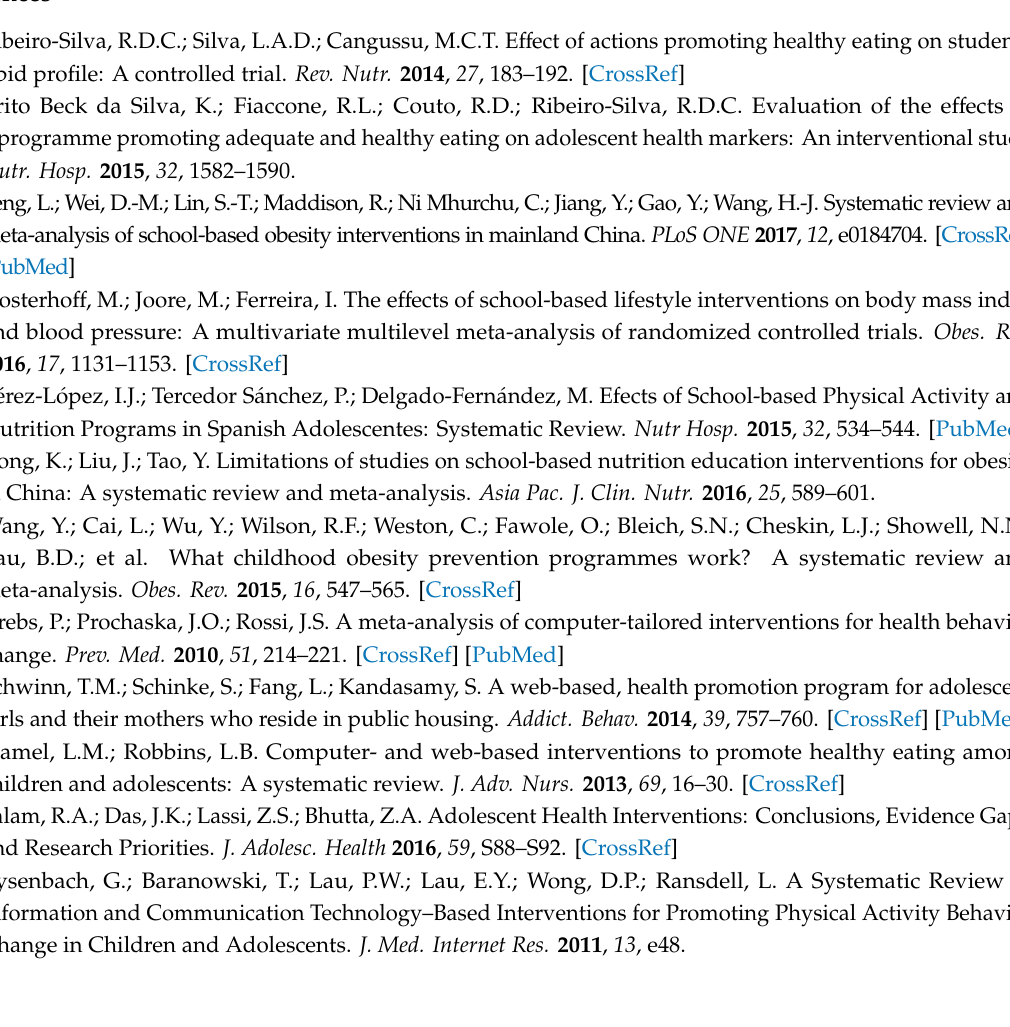
Table S1: Loss analyses between participants and dropouts of the study. Salvador, 2017, Table S2: Loss analyses between participants and dropouts of the study considering the intervention and control group. Salvador,